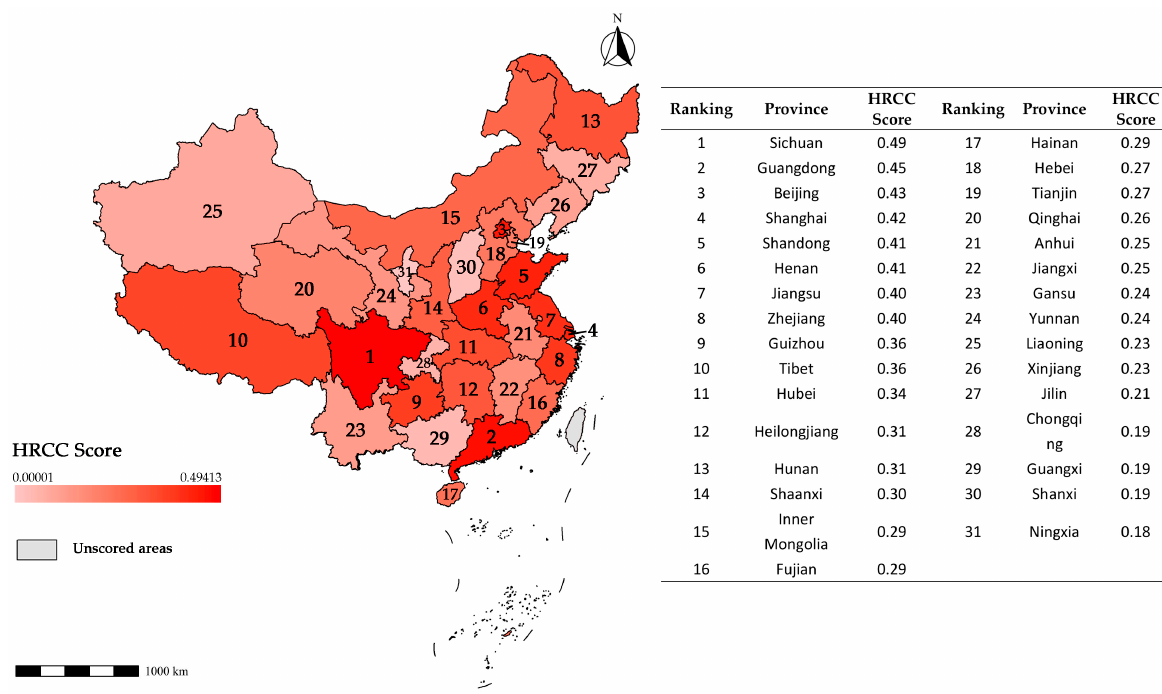
Figure 4. The HRCC scores in 31 provinces in mainland China.